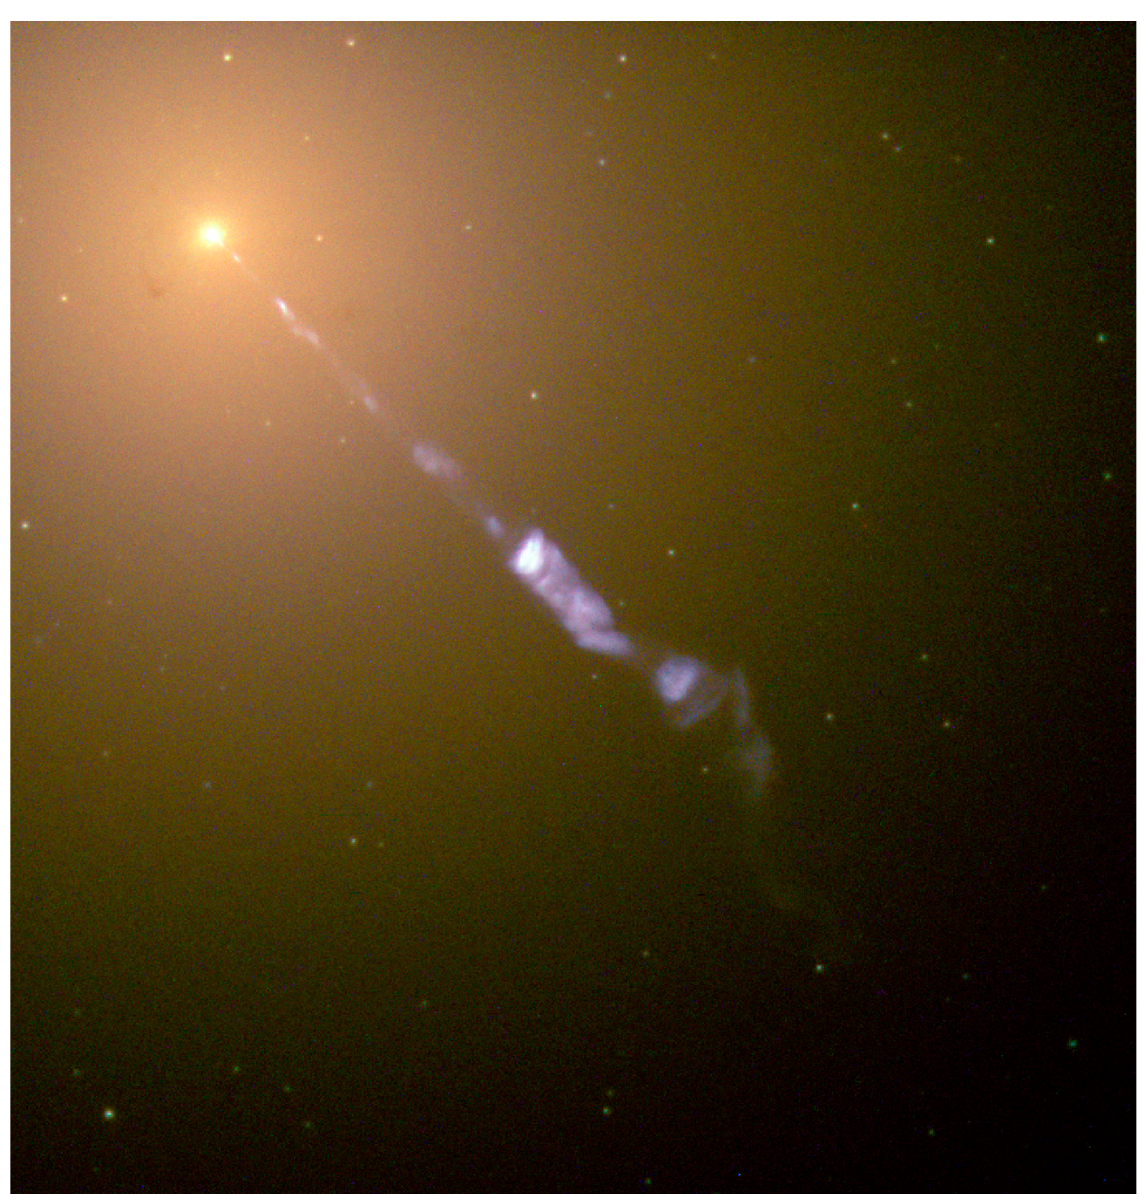
Figure 1. Nucleus of the M87 galaxy showing the relativistic jet blasting out from just outside of M87’s supermassive black hole. The jet, 4400 light-years long, is comprised of matter ejected at relativistic velocities by the supermassive black hole. Image credit: NASA/ESA/Hubble Heritage Team (STScI/AURA).